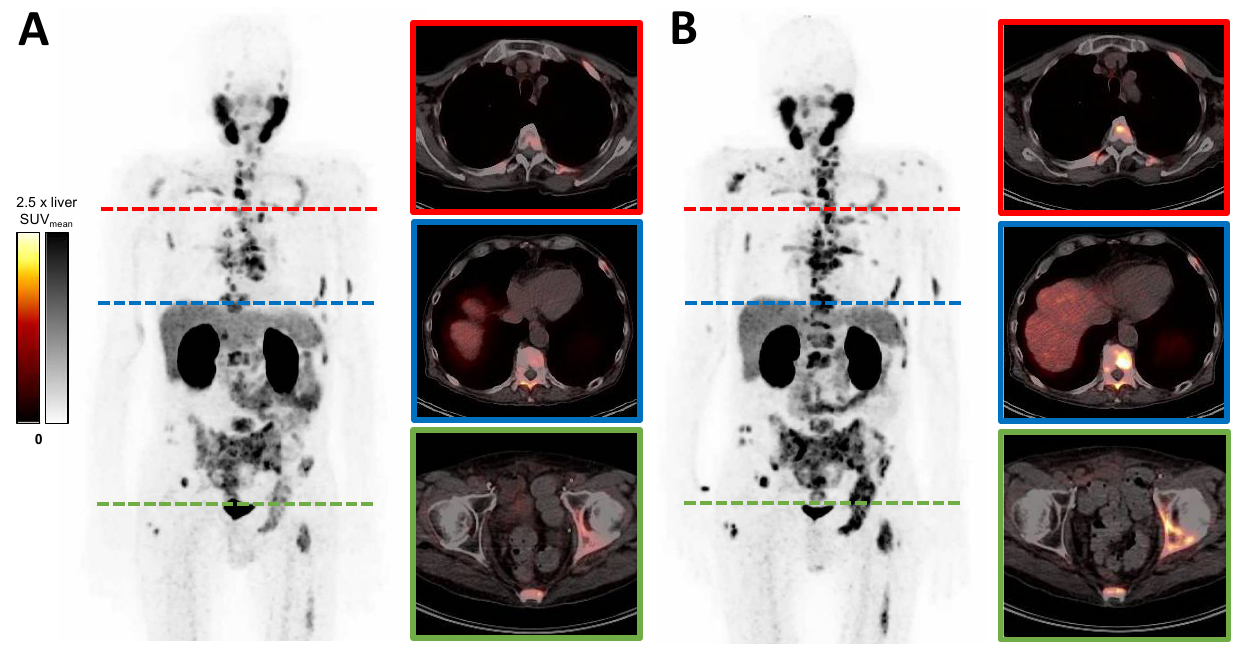
Figure 4. Example of a 68-year-old patient with predominantly bone metastases. Increased uptake can be seen in presented MIP (maximum intensity projection) and exemplary transversal slices of [ 68 Ga]Ga-PSMA-11 PET/CT ( A ) baseline (TLP 3611 mL × SUV, TLP-LR 840 mL × SUV/SUV, TLP-PR 455 mL × SUV/SUV, PSA 408 ng/mL) and ( B ) after 18 days of enzalutamide medication (TLP 6440 mL × SUV (+78.3%), TLP-LR 1464 mL × SUV/SUV (+74.3%), TLP-PR 688 mL × SUV/SUV (+38.0%), PSA 189 ng/mL (−53.7%)). SUV windowing was set from 0 to 2.5 times SUV mean of the liver.